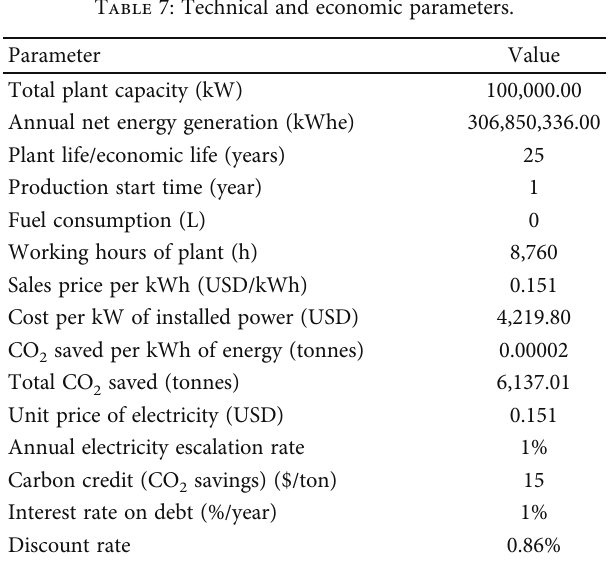
Table 7: Technical and economic